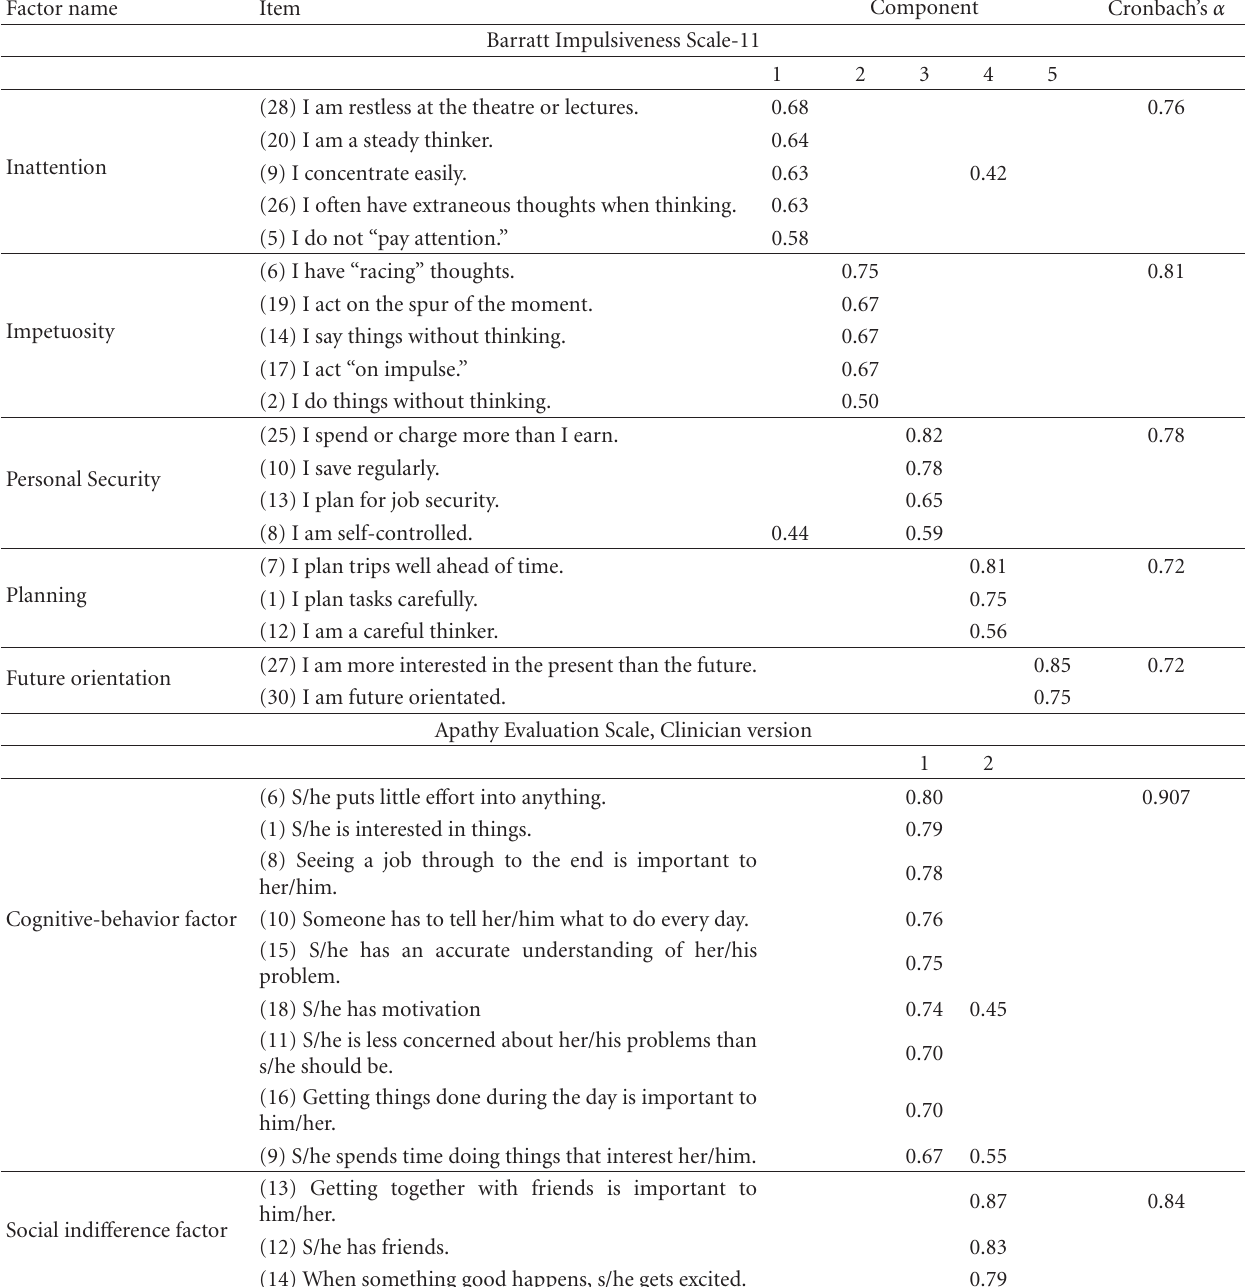
Table 2: Rotated component matrix for the Barratt Impulsiveness Scale-11 resulting in a five-factor solution and the Apathy Evaluation Scale, Clinician version, resulting in a two-factor